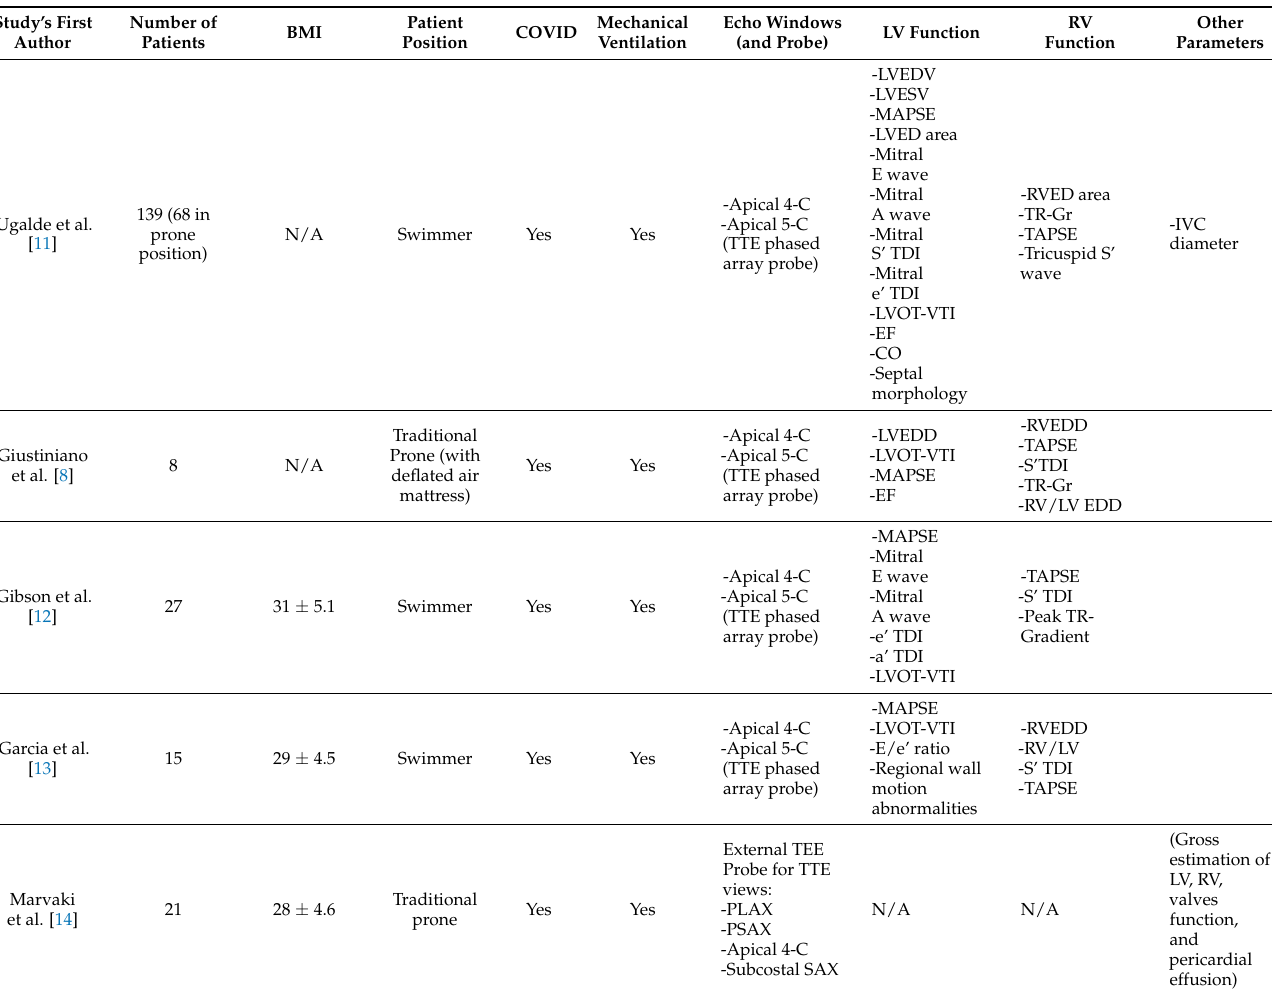
Table 1. Comparative overview of available studies on TTE in prone position. ** Swimmer position consists of patient’s face facing the hand and arm that is raised at a 90-degree angle. The alternate arm should be positioned down alongside the body with palm up. Modified swimmer position uses a 10 cm-high pillow placed in the ventral infraclavicular region to allow for better transducer placement and image detection. Abbreviations: CO, cardiac output; dPWT, posterior wall thickness in diastole; dSWT, septal wall thickness in diastole; EF, ejection fraction; IVC, inferior vena cava; LA, left atrium; LV GLS, left ventricular global longitudinal strain; LVEDV, left ventricular end-diastolic volume; LVESV, left ventricular end-systolic volume; LVEDD, left ventricular end-diastolic diameter; LVESD, left ventricular end systolic diameter; LVOT-VTI, left ventricular outflow tract—velocity time integral; MAPSE, mitral annular plane systolic excursion; N/A, not available; PAPs, pulmonary artery systolic pressure; PLAX, parasternal long axis view; PSAX, parasternal short axis view; RV LS, right ventricular longitudinal strain; RV FAC, right ventricular fractional area change; RV/LV, right ventricular-left ventricular ratio; RVEDD, right ventricular end diastolic diameter; TAPSE, tricuspid annular plane systolic excursion; TDI, tissue Doppler imaging; Tr-Gr, tricuspid regurgitation